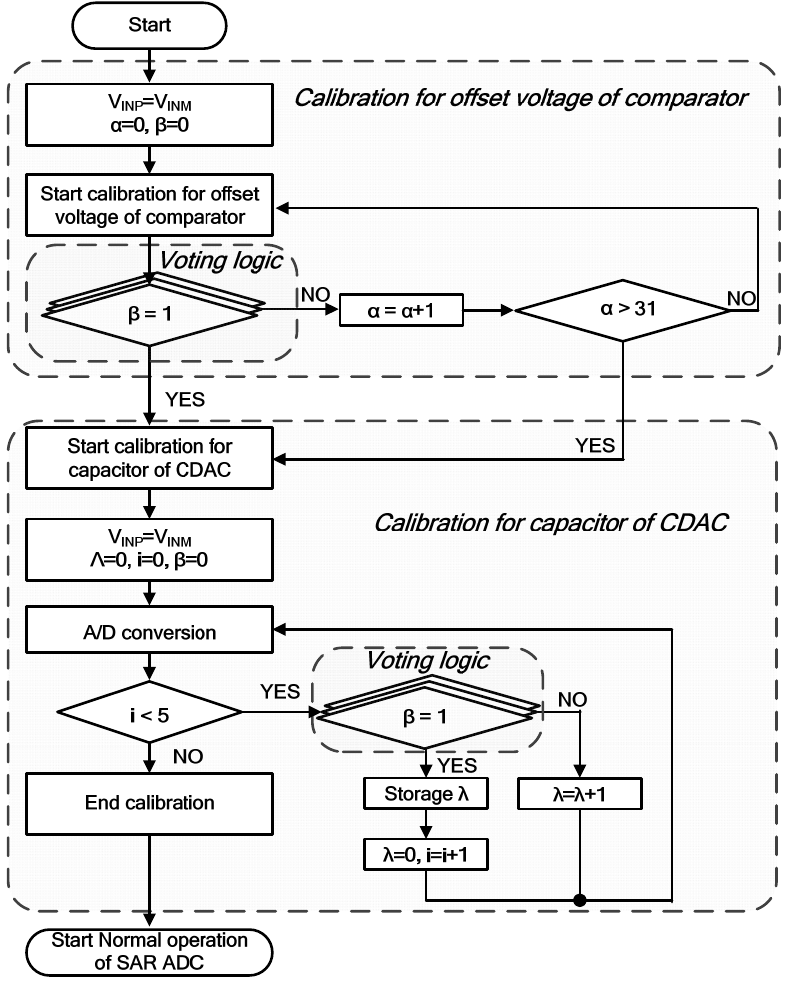
Figure 3. Sequence of C–R DAC calibration including comparator offset Figure 3 . Sequence of C–R DAC calibration including comparator offset calibration.